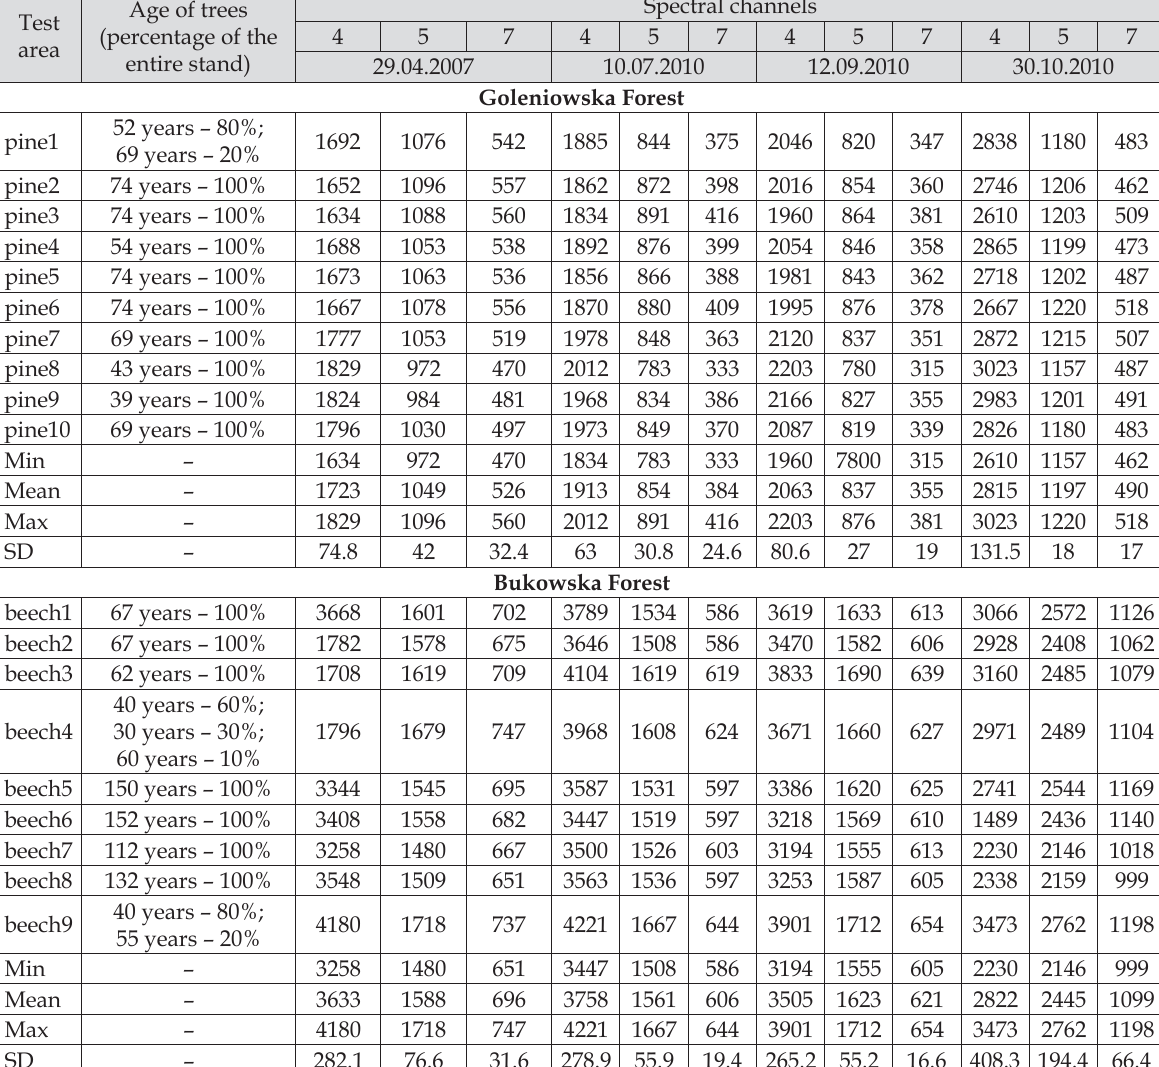
Table 2. Values for spectral reflectance [SRFI] of infrared radiation (channels 4, 5 and 7) for beech and pine stands at various points of the vegetation